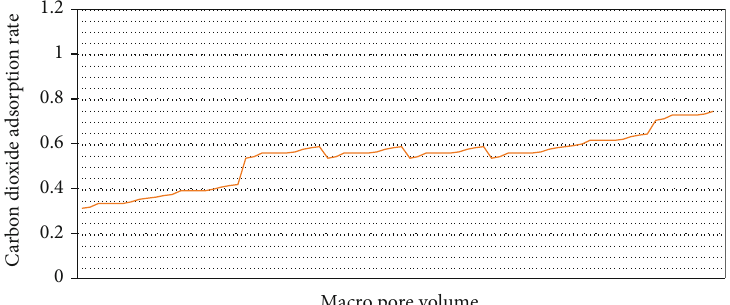
Figure 5: Representation of the data statistics for the input ( CO collected from the dataset in [7,